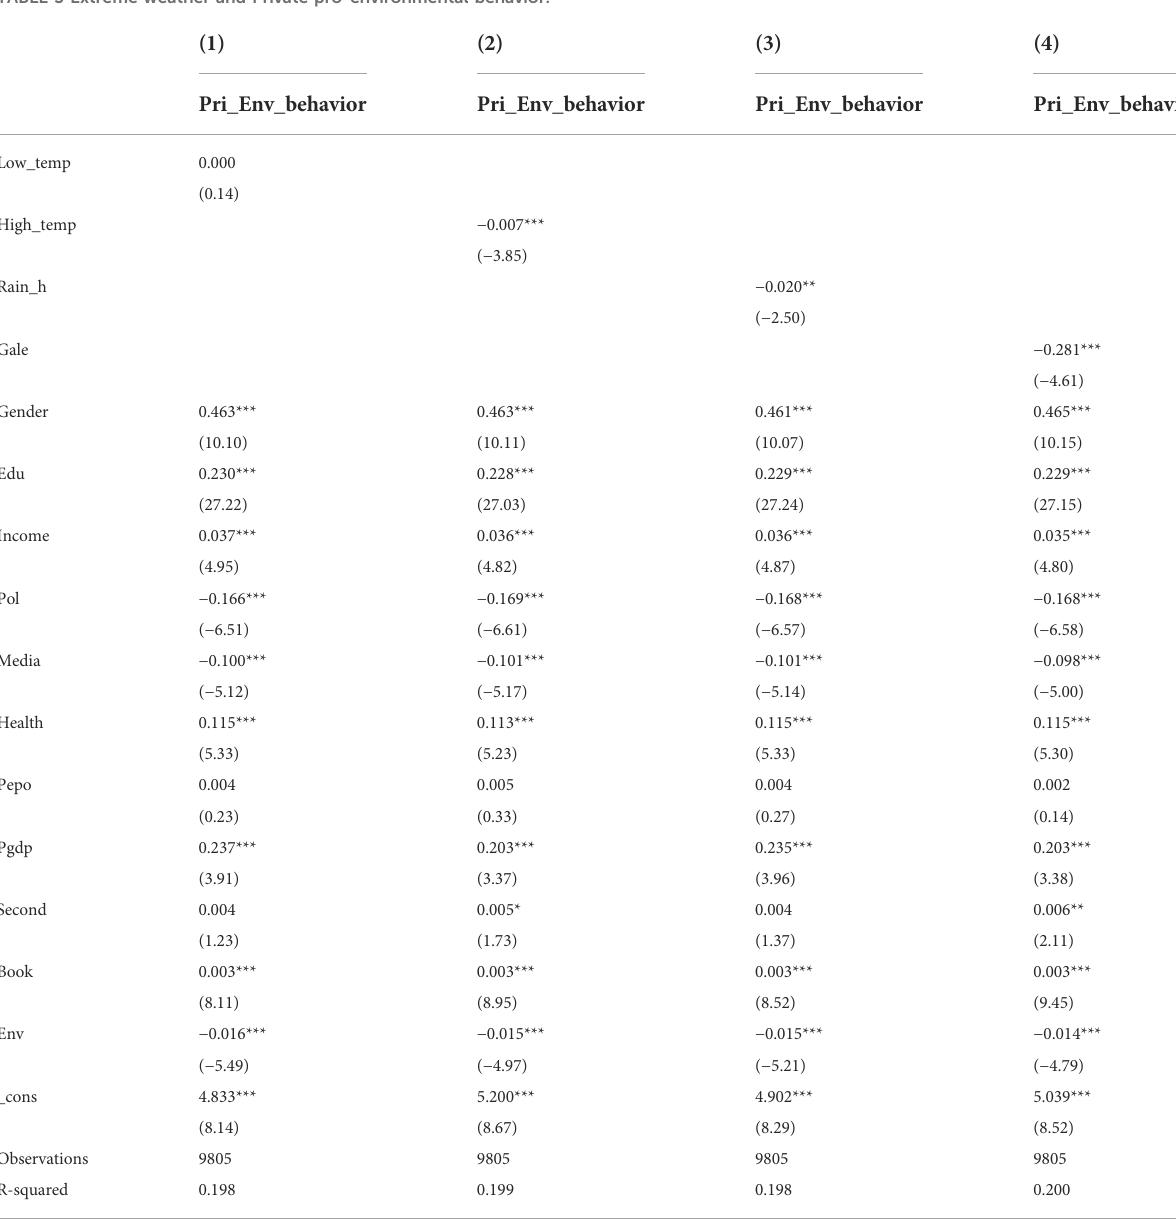
TABLE 3 Extreme weather and Private pro-environmental